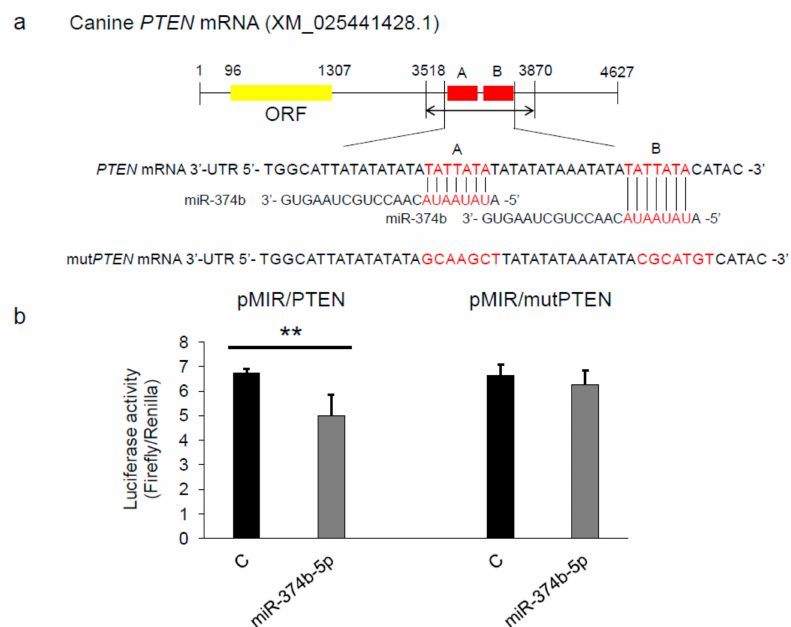
Figure 5. miR-374b-5p directly targeted PTEN. ( a ) Binding sites (A and B) of miR-374b in the 3 (cid:48) UTR of canine PTEN mRNA. The wild-type binding sites were changed to the mutated ones as indicated. ( b ) Results of the luciferase activity assay using the pMIR reporter vector harboring the wild-type or mutated 3 (cid:48) UTR of canine PTEN mRNA (the region of 3518 to 3870). The assay was performed 24 h after co-transfection with the reporter vector and miRNA. ** p < 0.01, for di ff erences between the cells transfected with the negative control and miR-374b-5p. Data are expressed as the mean + SD ( n = 3).